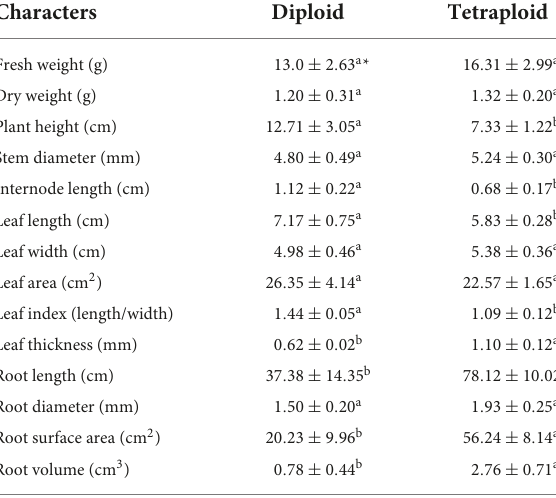
TABLE 1 Morphological characteristics of diploid and tetraploid A. roxburghii.